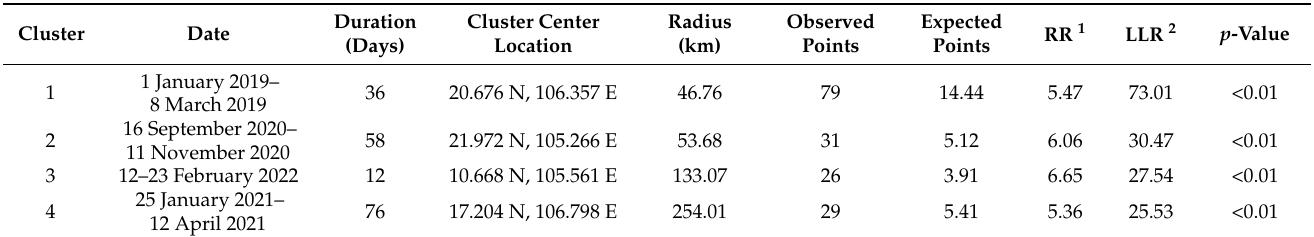
Table 4. Spatiotemporal high-risk clusters of the ASF outbreaks in Vietnam (February 2019– March 2022).